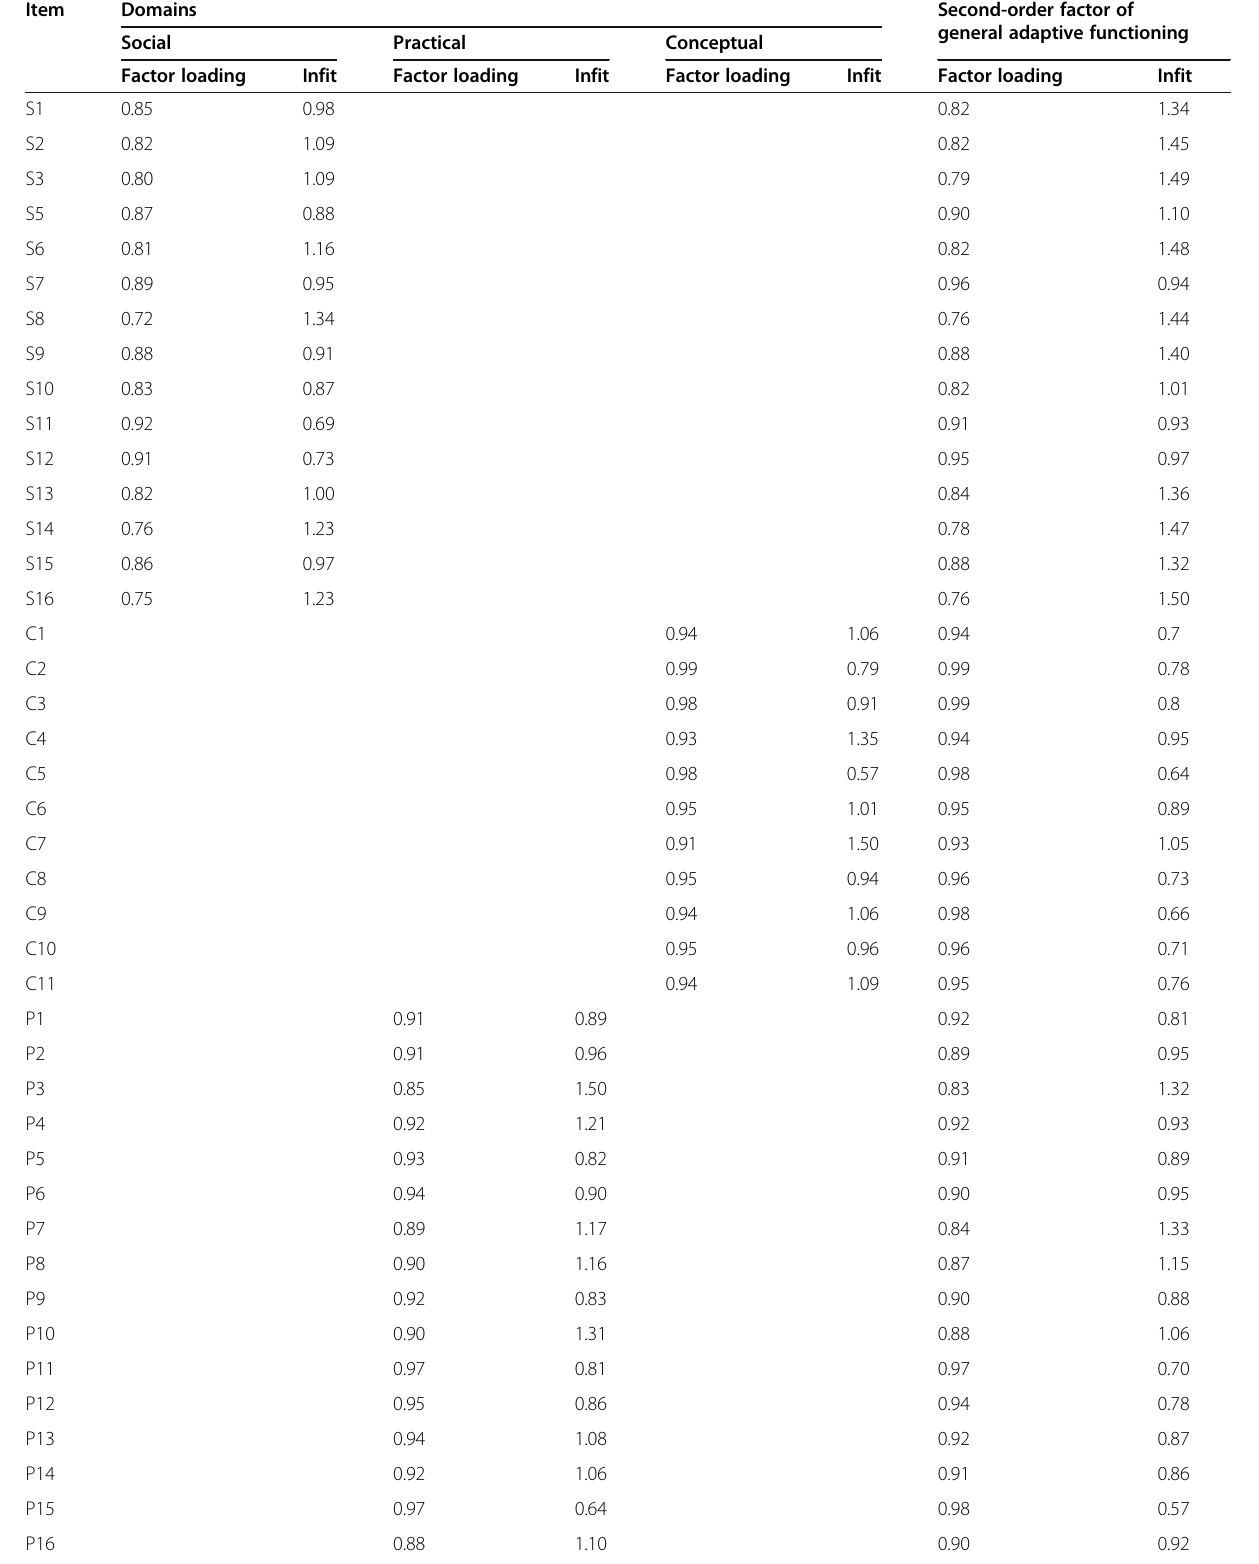
Table 3 Parameters of confirmatory factor analysis and item response item